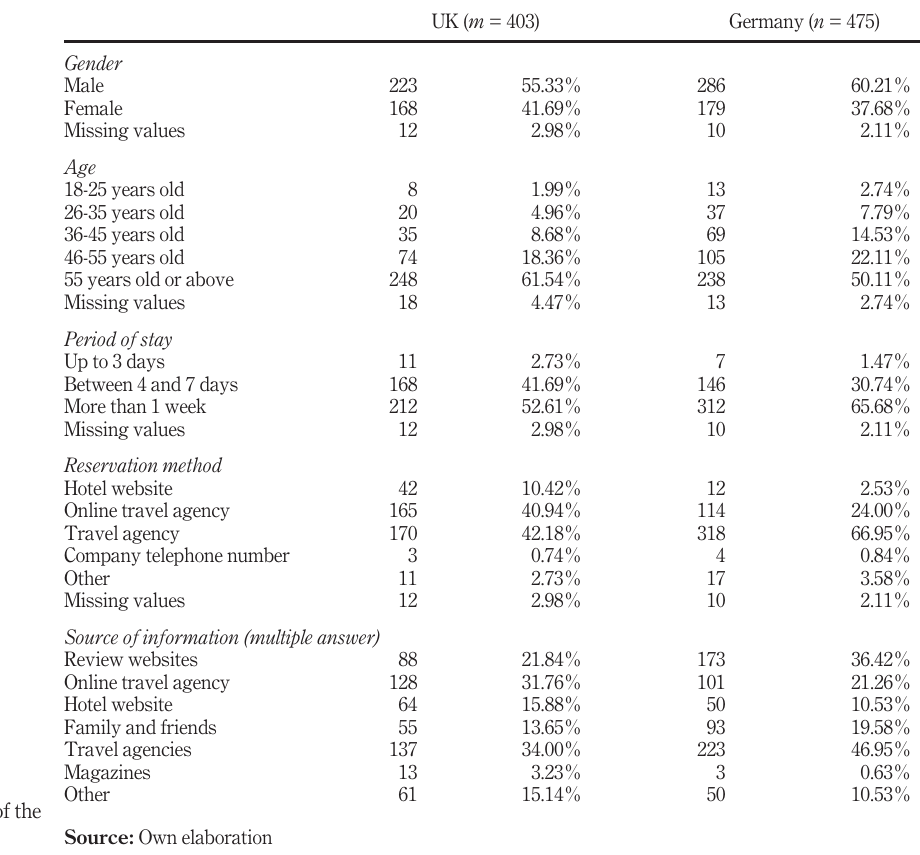
Table I. Demographic characteristics of